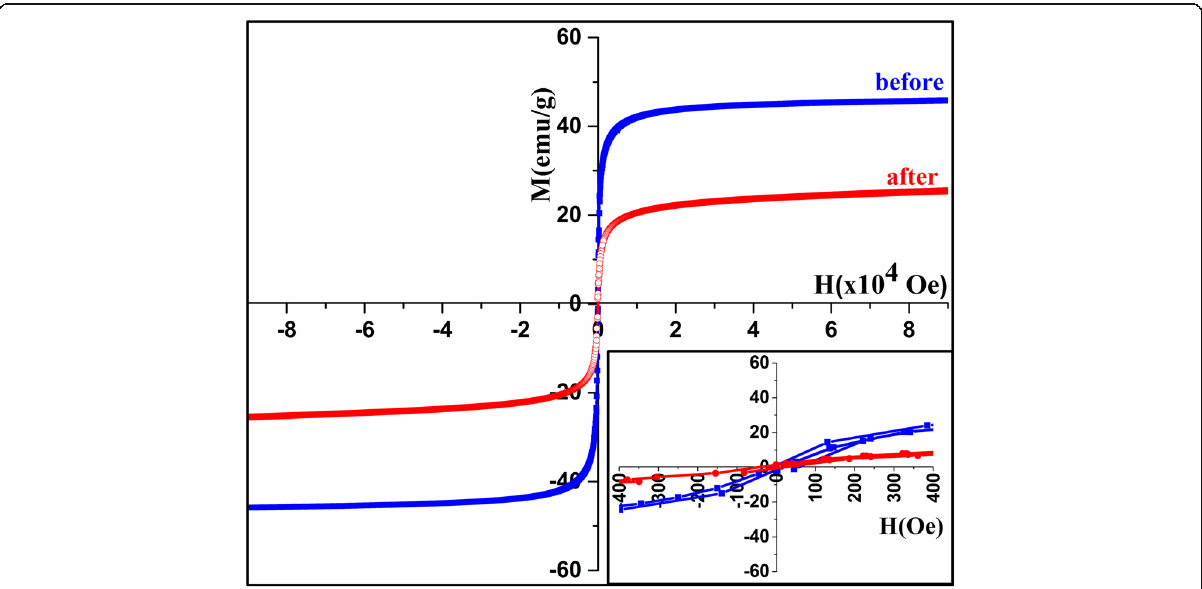
Fig. 11 Hysteresis loops for Au/Fe 3 O 4 nanoparticles before and after heating to 900 K (inset at low magnetic field) (blue, before heating; red, after heating) (inset shows the hysteresis loops at low